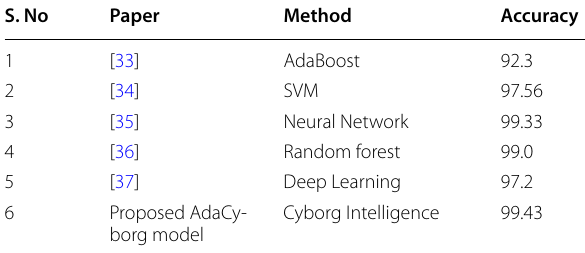
Table 3 Results comparison with existing works